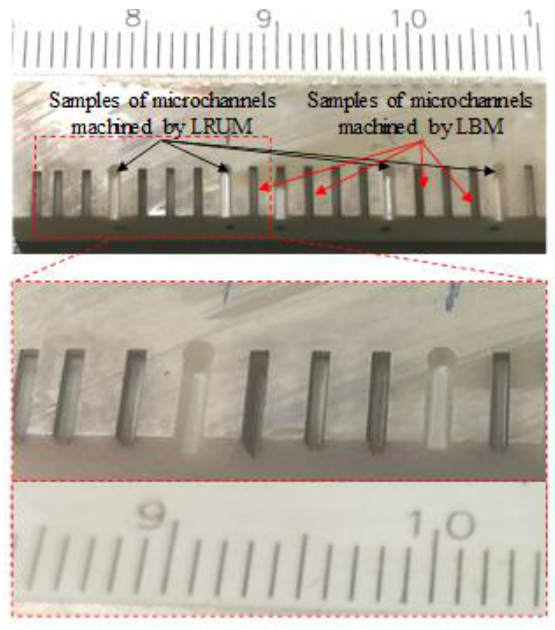
Figure 8. Samples of microchannels fabricated under the optimal conditions of LBM and LRUM.